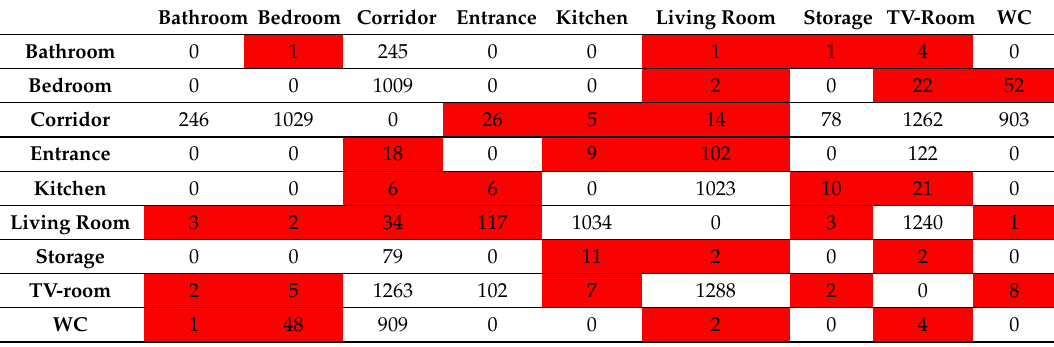
Figure 9. Re-deployment phase process mining data analysis. Table 2. Confusion matrix of transitions in re-deployment phase. Transitions between non-adjacent locations have been marked in red as false detections.